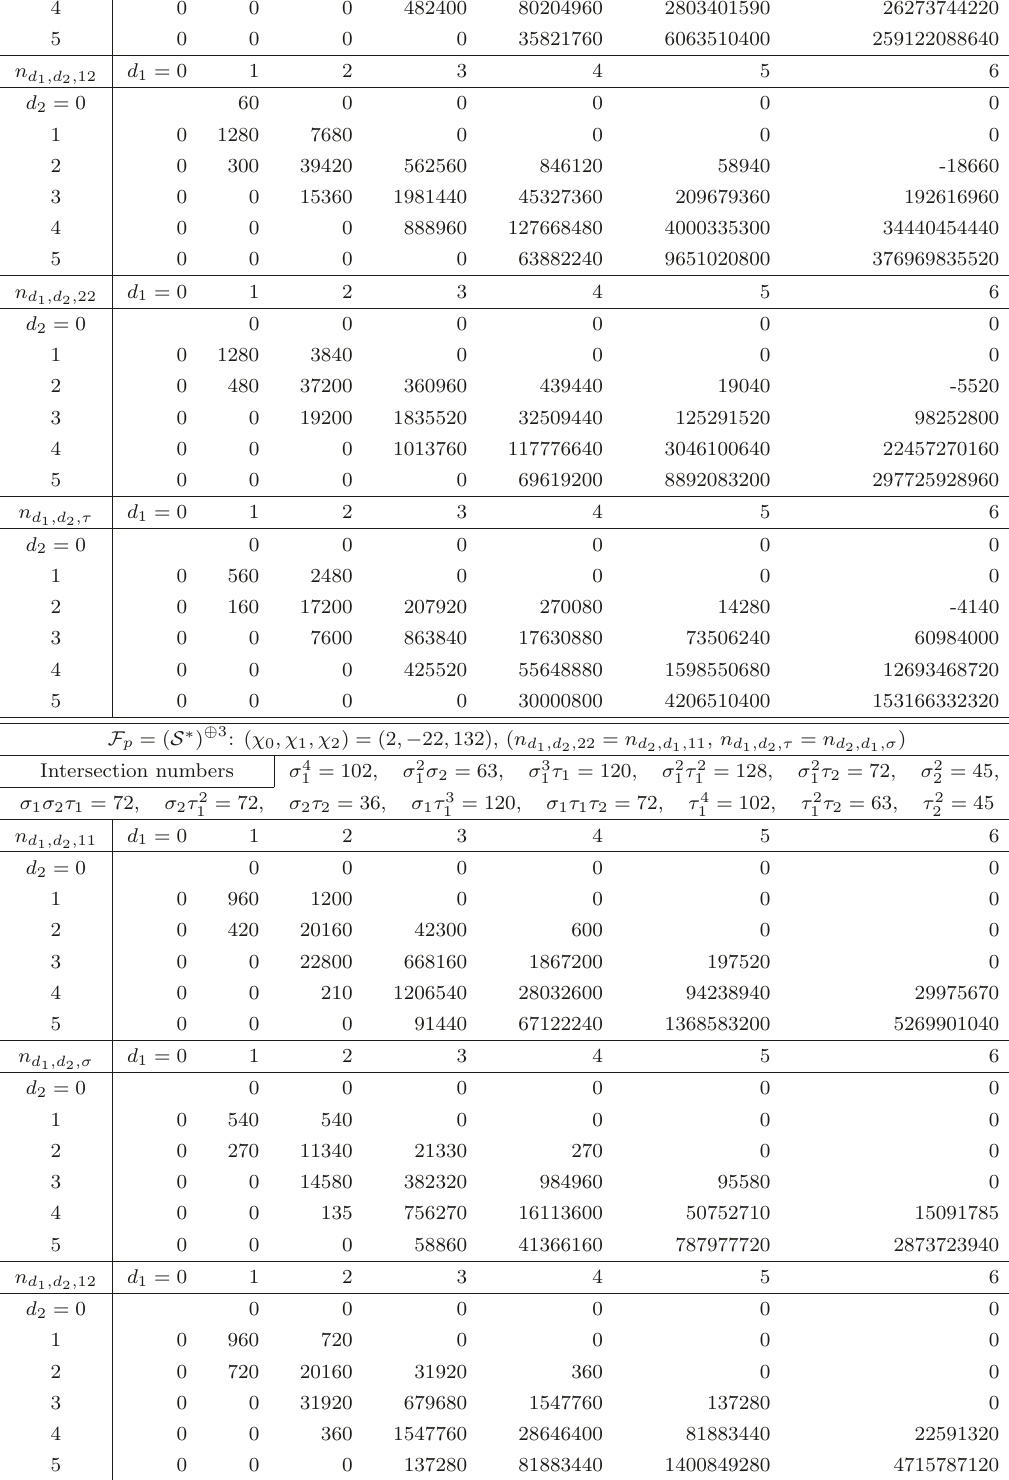
Table 8 . Genus-0 invariants of determinantal 4-folds in (A.8) with V = G (2 ,